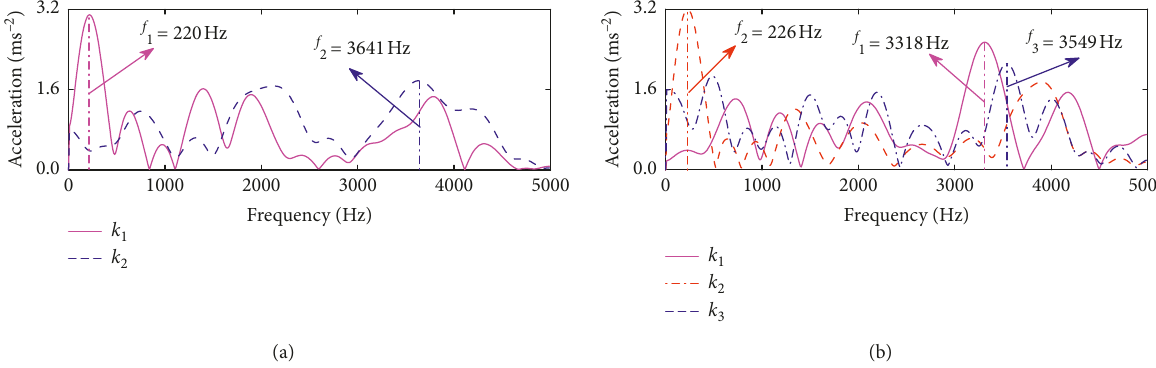
Figure 34: Main frequencies for estimating the types of impulse responses.